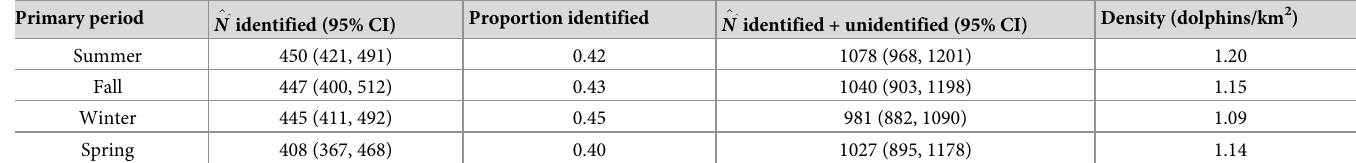
Table 5. Estimated abundance (95% CI) by primary period for the Indian River Lagoon dolphin population (2016–2017). Primary period